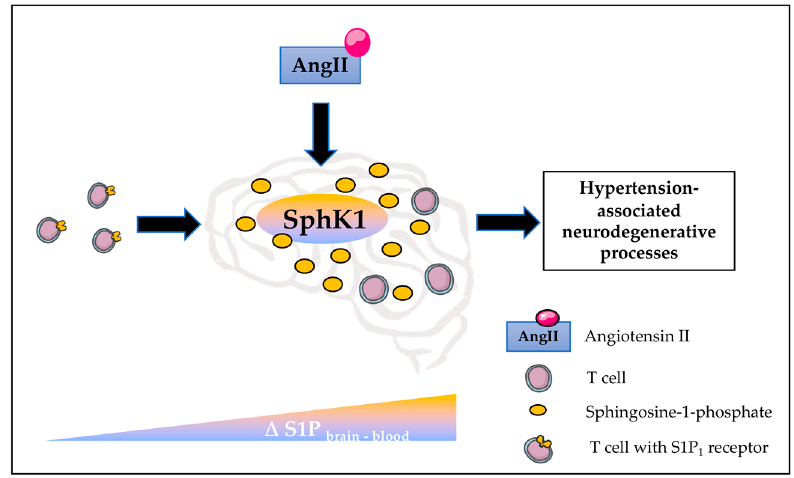
Figure 4. Central illustration. AngII stimulates an SphK1-mediated elevation of brain S1P concentrations, which establishes an S1P gradient between the brain and the circulating blood that allows S1P-governed T cell infiltration to the brain. AngII—angiotensin II, S1P—sphingosine-1-phosphate, S1P 1 —S1P receptor type 1.